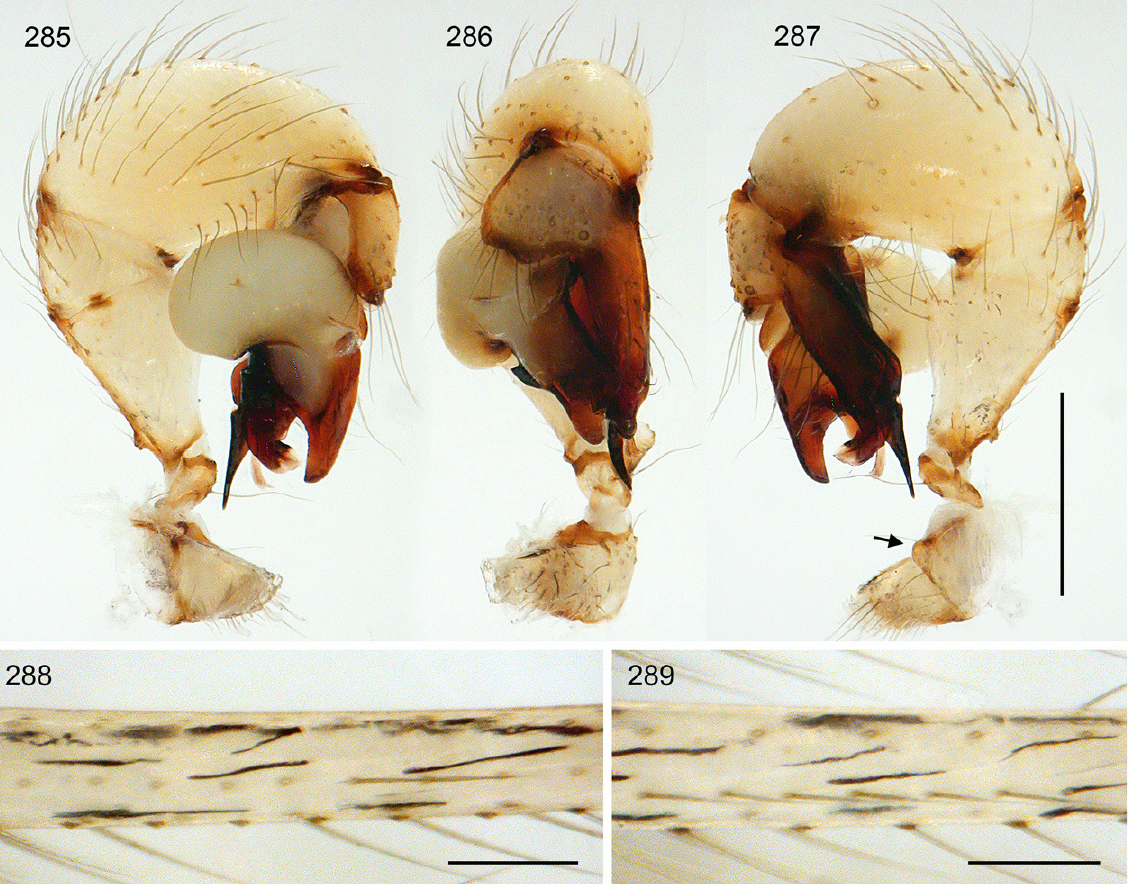
Figs 285–289. Maghreba aurouxi (Barrientos, 2019) gen. nov.; male from Morocco, SE of Zebzat (ZFMK Ar 22385). 285–287 . Left palp, prolateral, dorsal, and retrolateral views; arrow: process on coxa. 288–289 . Femora 3 and 4, ventral views. Scale bars: 285–287 = 0.5 mm; 288–289 = 0.2